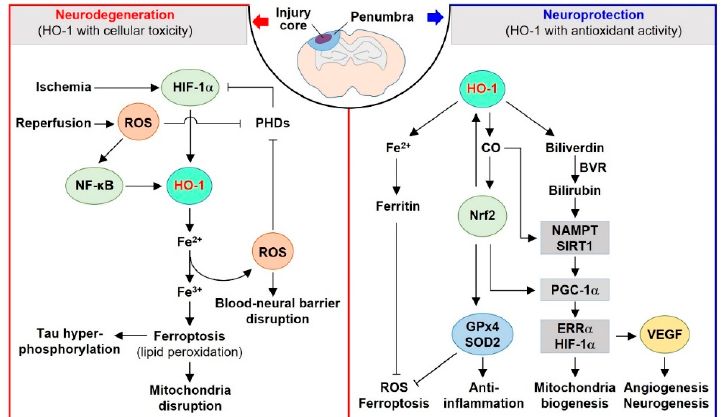
Figure 1. Dual effects of heme oxygenase (HO)-1-related signaling. In the injury core, long-term and high expression of HO-1 can lead to cellular iron accumulation, excessive reactive oxygen